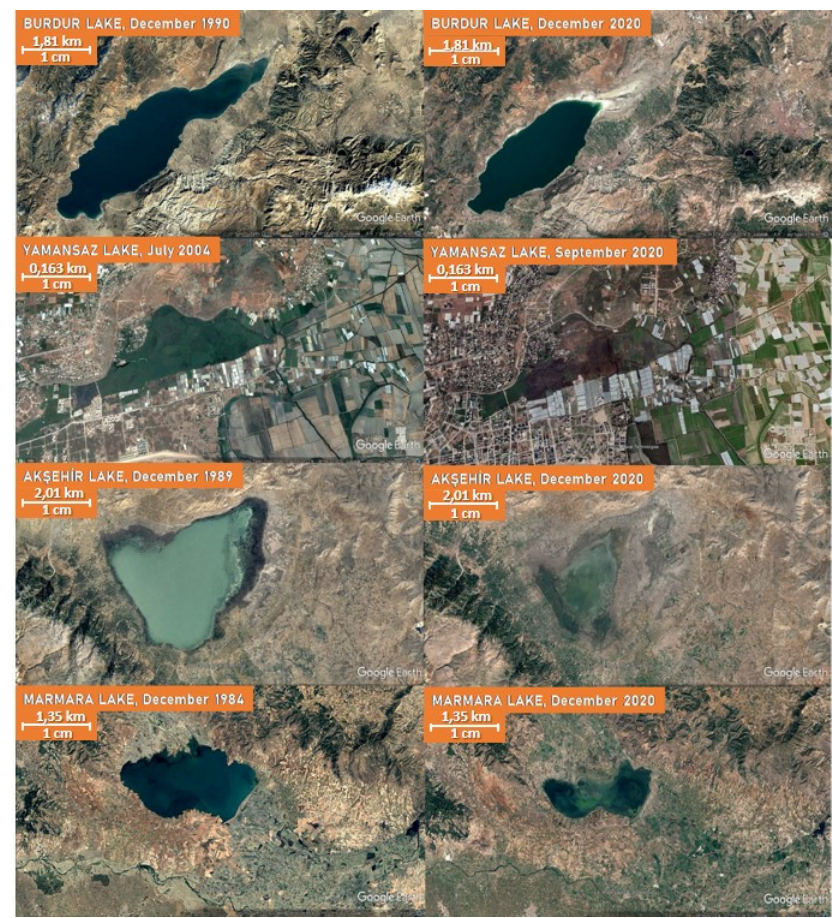
Figure 5. Satellite images from Google Earth showing the trend of water level decrease in the last decades in some Turkish lakes.